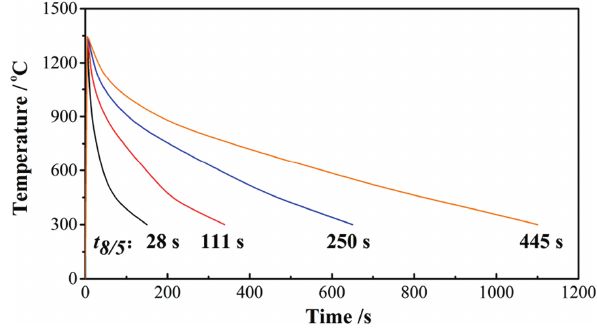
Figure 1: The temperature variation during the simulating thermal cycle